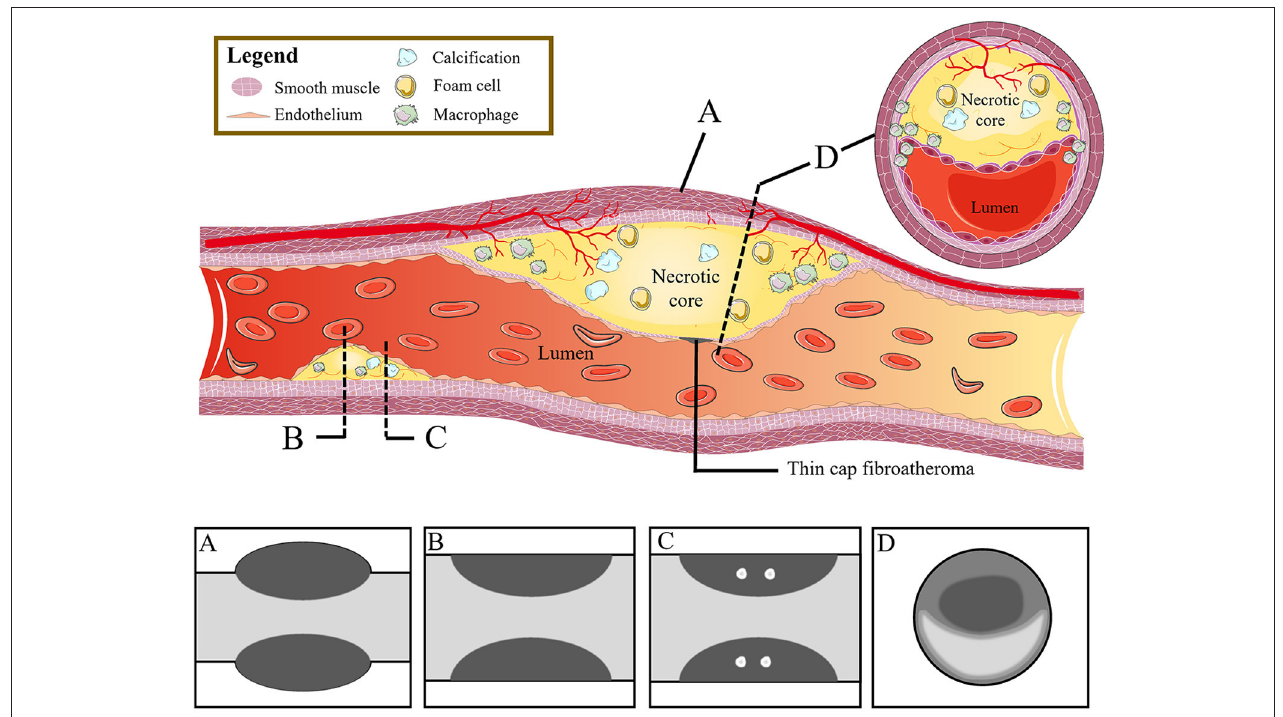
FIGURE 1 | From high-risk plaque histopathology to CCTA. The figure shows the histopathologic components of vulnerable plaques (colored illustrations) and the corresponding typical CT features of high-risk plaques: (A) positive remodeling, (B) low attenuation, (C) spotty calcification, and (D) napkin-ring sign. CCTA, coronary computed tomography angiography.